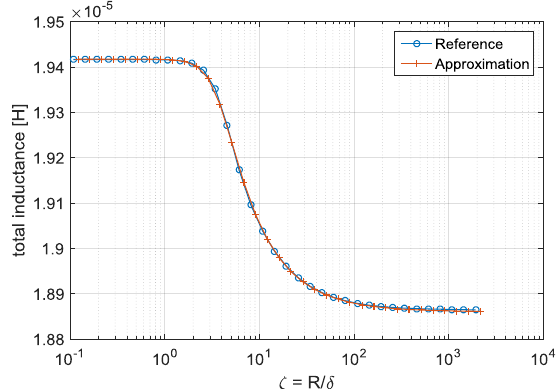
Figure 7: Semi logarithmic plot of the reference and the approximated total inductance in function of the dimensionless frequency 𝜁